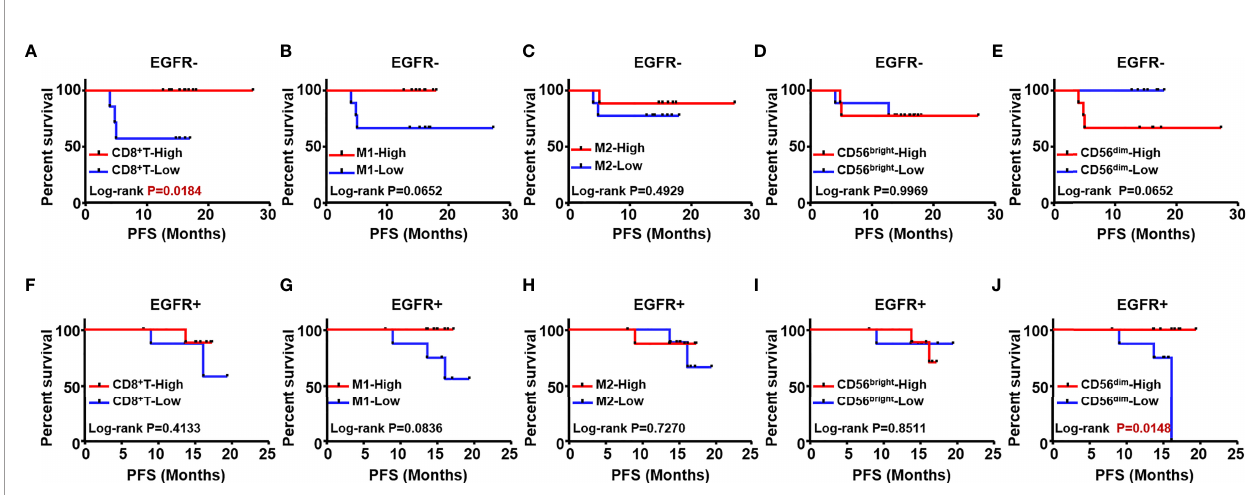
FIGURE 6 | The prognostic value of different immune cells was evaluated in NSCLC patients with and without EGFR mutation. Kaplan Meier estimates for PFS; Patients without EGFR mutation (EGFR-) were strati fi ed according to CD8+T (A) , M1 macrophages (B) M2 (C) CD56bright NK (D) and CD56dim NK (E) Patients with EGFR mutation (EGFR+) were strati fi ed according to CD8+T (F) M1 macrophages (G) M2 (H) CD56bright NK cells (I) and CD56dim NK cells (J) .